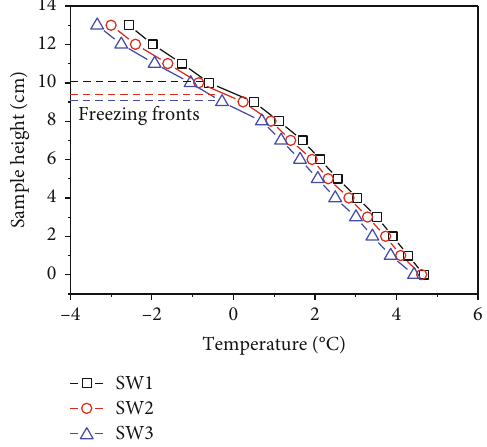
Figure 3: Temperature distribution in the samples after freezing for 120